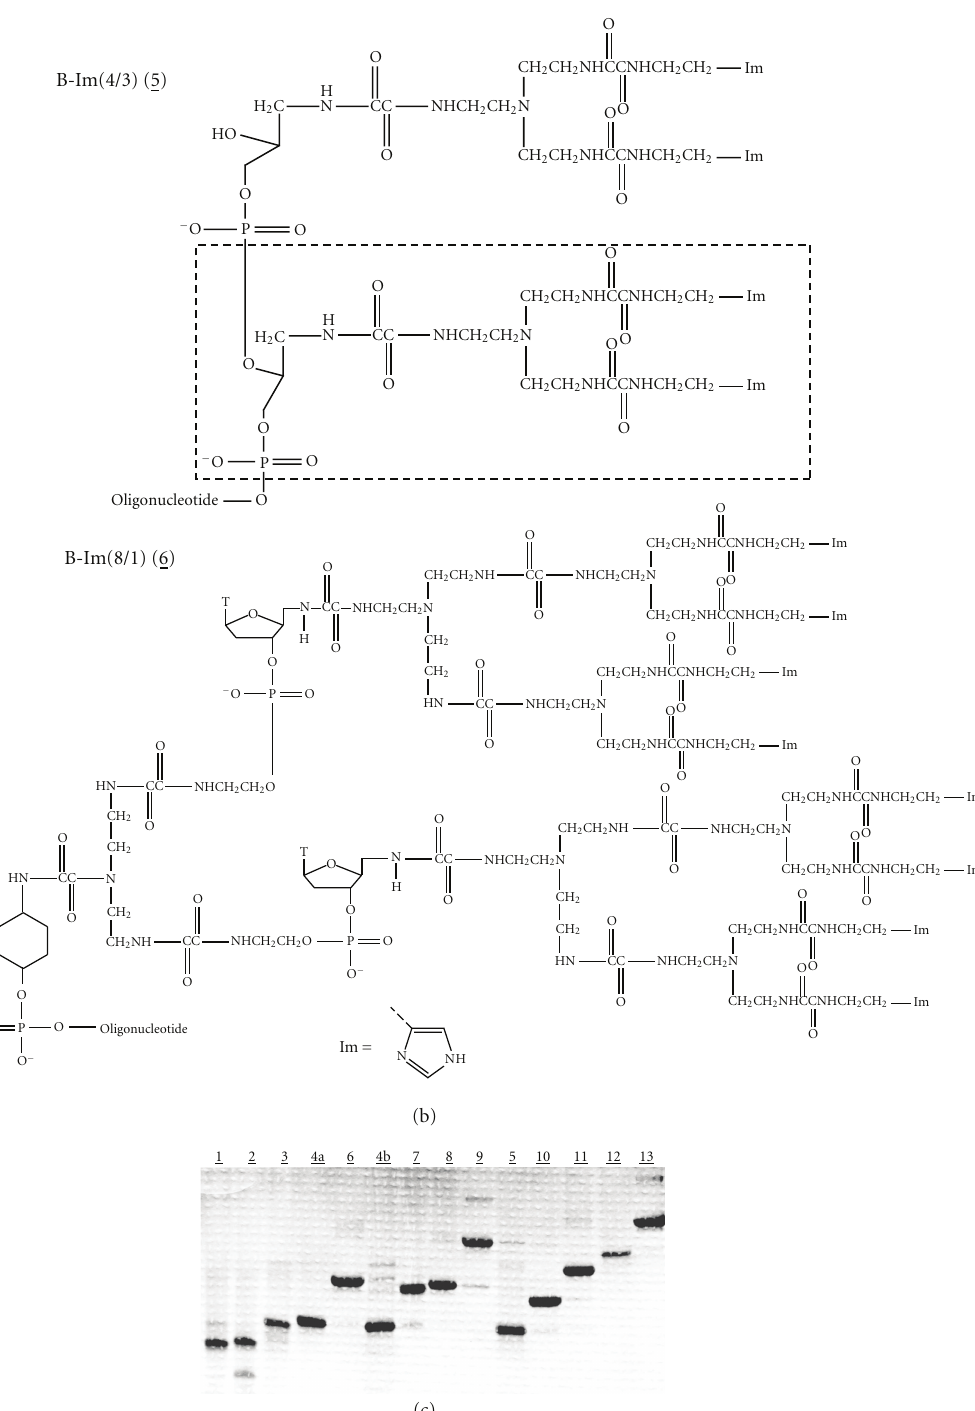
Figure 1: Schematic representation of the catalytic structures of the site-selective artificial ribonucleases B-Im(N/m) and analysis of the conjugates. (a) Anchor groups used for attachment of dendrimeric RNA-cleaving constructs to oligonucleotide B 5 (cid:2) -phosphate. (b) Schematic represen- tation of conjugates bearing four and eight imidazole residues and anchor groups of Type1, Type 2, and Type 3, obtained using precursor technology. Mass spectrometry data: 1 : calculated mass 5523.30, found mass 5523.73; 2 : 5566.80/5566.39; 3 : 5692.89/5692.03; 4a: 6838.95/ 6838,65; 5 : 6423.63/6425.03. (c) Analysis of the conjugates B-Im(N/m) by 12% polyacrylamide/8 M urea gel electrophoresis. 0.1 A 260 unit of each conjugate was applied on the gel; the conjugates were visualized in the gel by staining with Stains-All. Numbers on the top of the gel correspond to numeration of the conjugates in the Table 1 and Figure 1(b) and Supplementary Material Figure